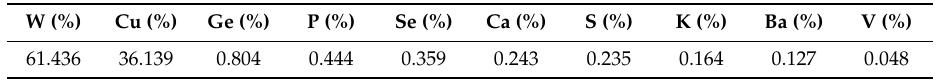
Table 4. Chemical composition by weight (wt %) of the fixed contact at the “Cut X” point of Figure 6b according to the chemical analysis test.